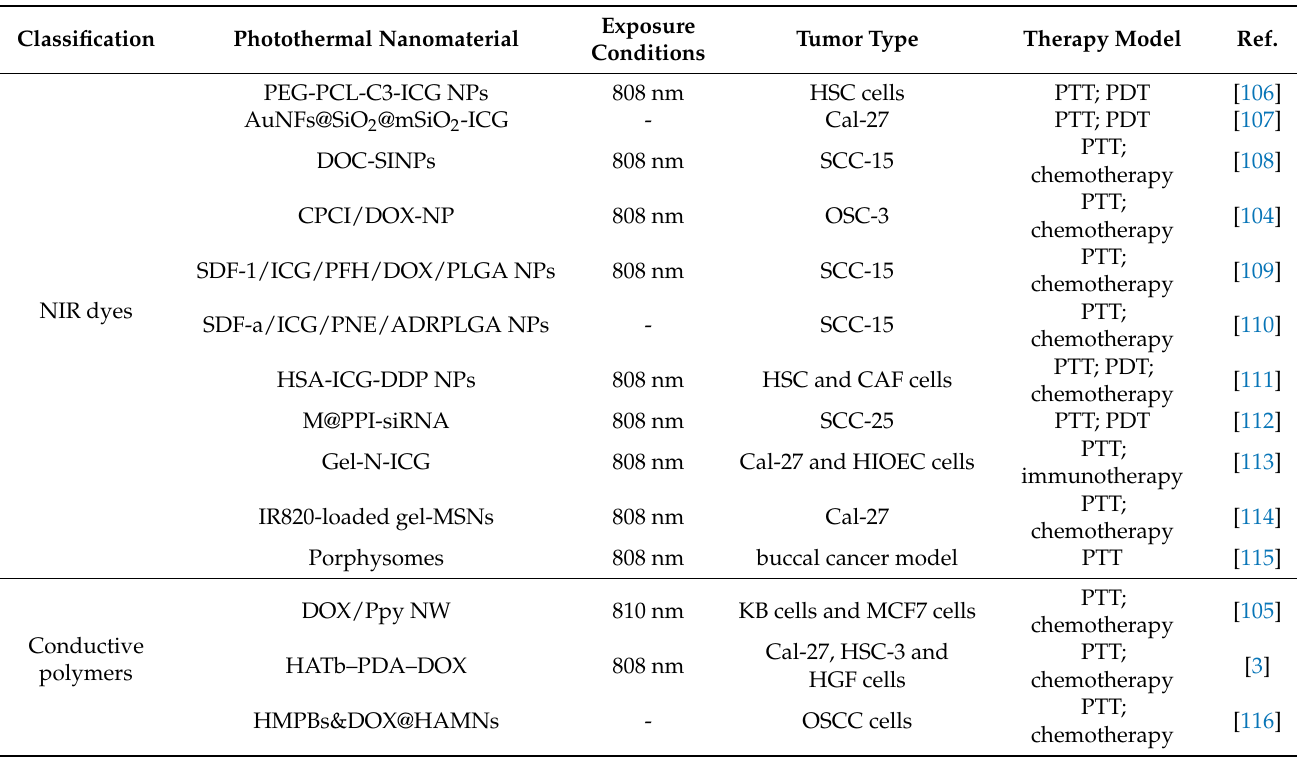
Table 3. A summary of organic nanomaterials for PTT in